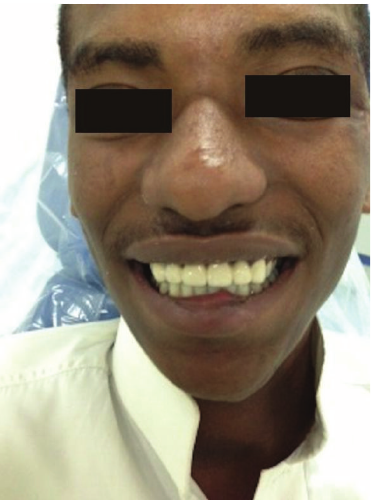
Figure 7: Final definitive porcelain fused with metal prosthesis in patient